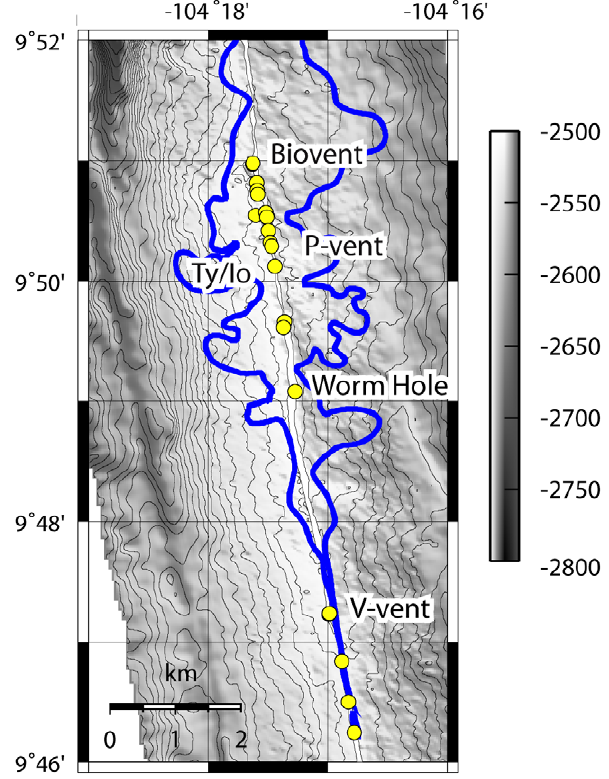
Figure 1. Map of vent locations on ridge axis of East Pacific Rise near 9 6 50 9 N. Vents (yellow circles) referenced in text are named. Blue outline shows extent of lava from 2006 eruption.